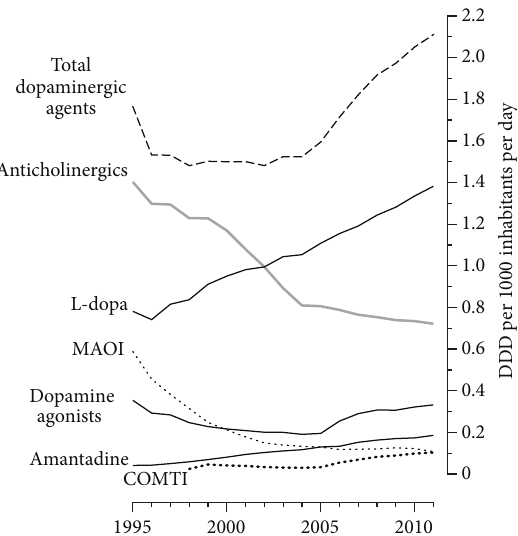
Figure1:ChangeinthevolumeofantiparkinsonianagentgroupsinNewZealand1995–2011.TotaldopaminergicagentsrefertoATCcategory N04B and exclude anticholinergics. L-dopa: levodopa, MAOI: monoamine oxidase inhibitor, and COMTI: catechol-o-methyl transferase inhibitors. DDD: defined daily